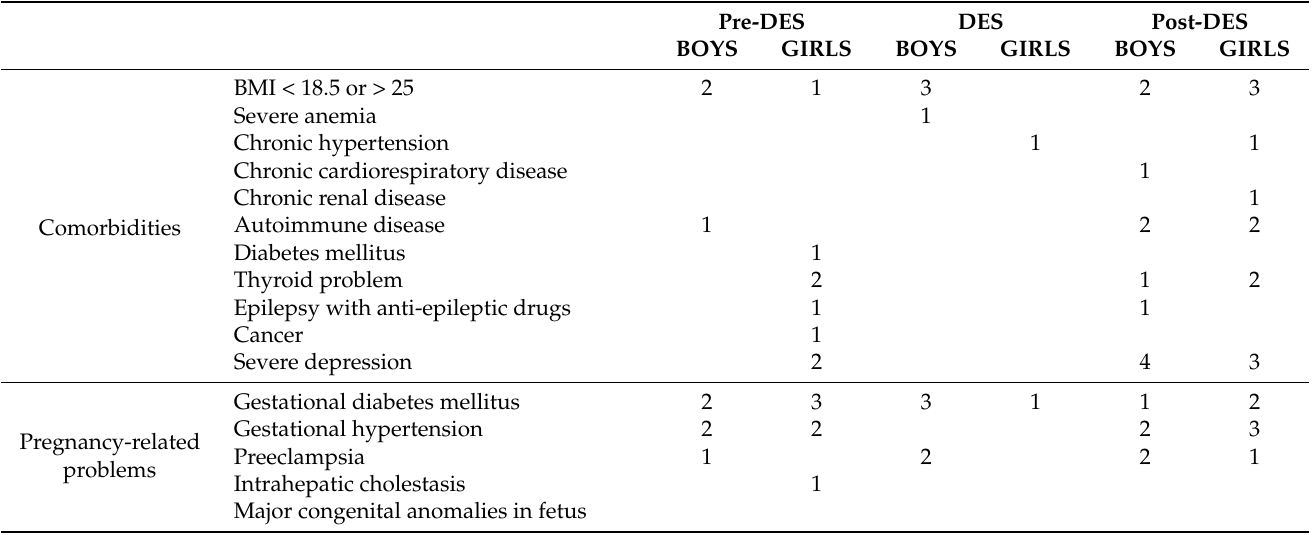
Table 5. Characteristic of G1 mothers (G1 daughters or partners of G1 sons, when adults) excluded from the analysis. More than one answer was possible.